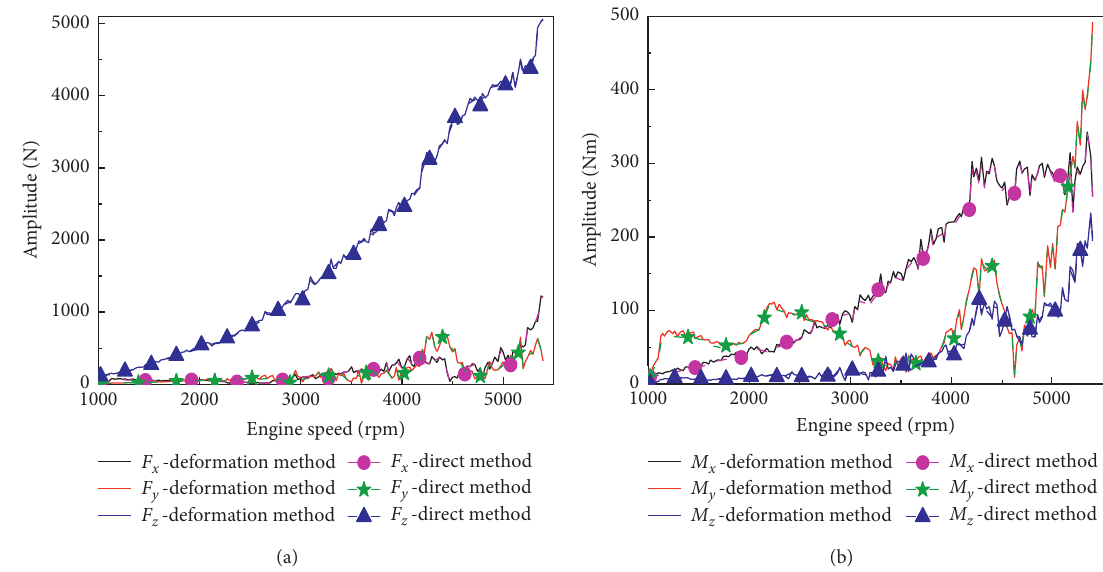
Figure 8: Excitation forces of powertrain under the second gear WOT condition. (a) Excitation forces. (b) Excitation